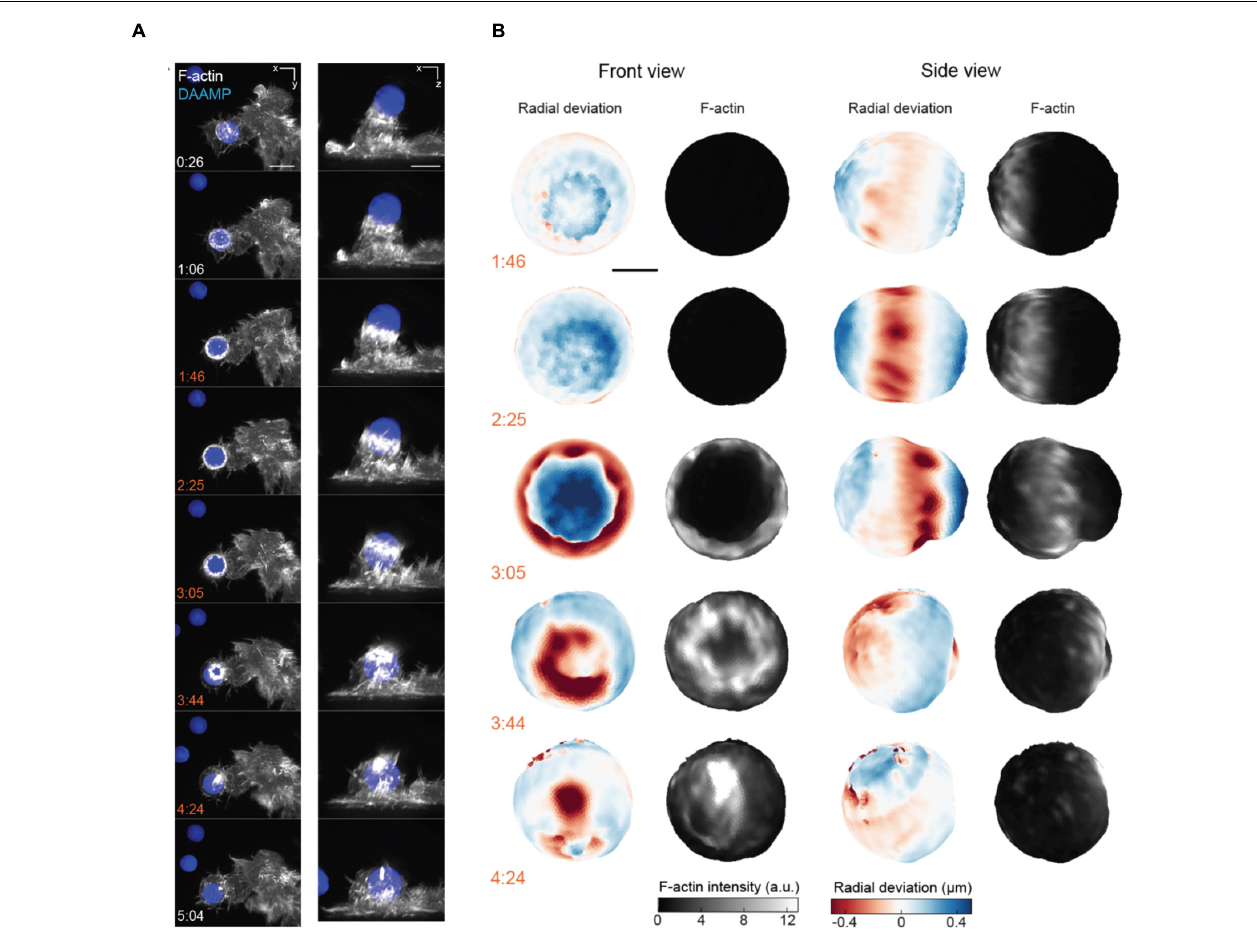
FIGURE 7 | 3D LSFM combined with microparticle traction force microscopy monitors target deformation during phagocytosis. (A) Maximum intensity projections of RAW macrophages expressing Lifeact-mEmerald (white) engulfing deformable particles labeled with AlexaFluor 647 (blue) imaged with LLSM. Time is given in minutes:seconds, scale bar: 5 µ m. (B) Front and side view projections of target deformations and actin intensity around the target particle at various time points during the engulfment process. Time denoted in minutes:seconds, scale bar: 3 µ m. Images are reproduced with permission from Vorselen et al.